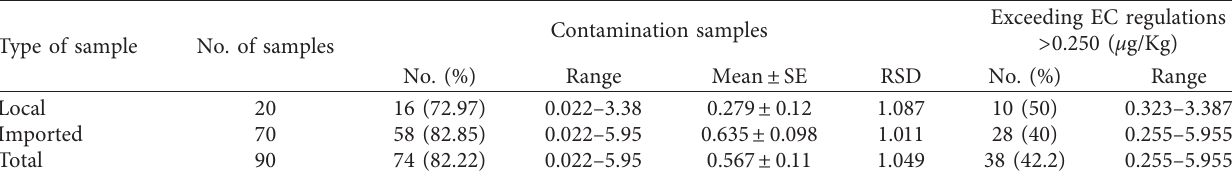
Table 5: AFM1 in cheese samples through